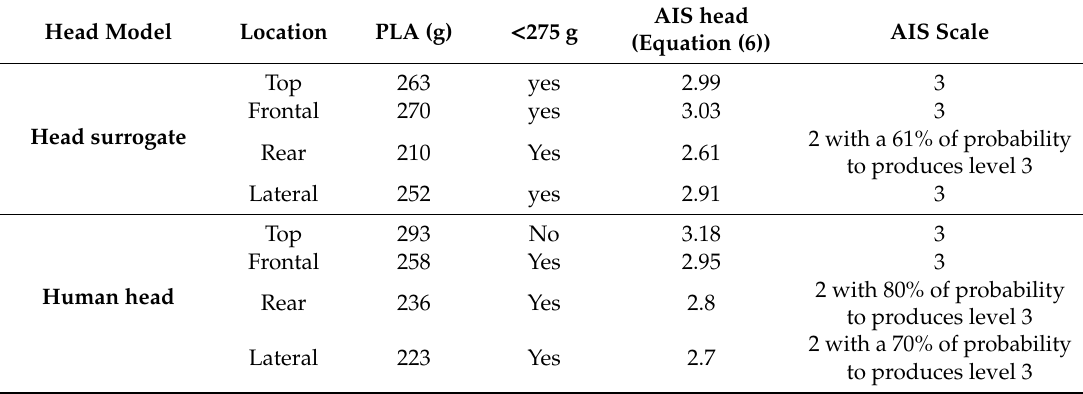
Table 6. Results for an impact velocity of 4.4 m / s for the head surrogate and the human head. Head